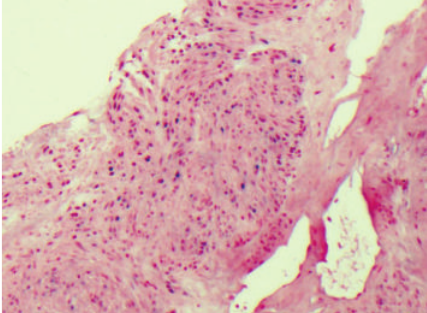
Figure 6: In situ hybridization for EBV early RNA: “blue dots” are positive nuclear staining ( × 100